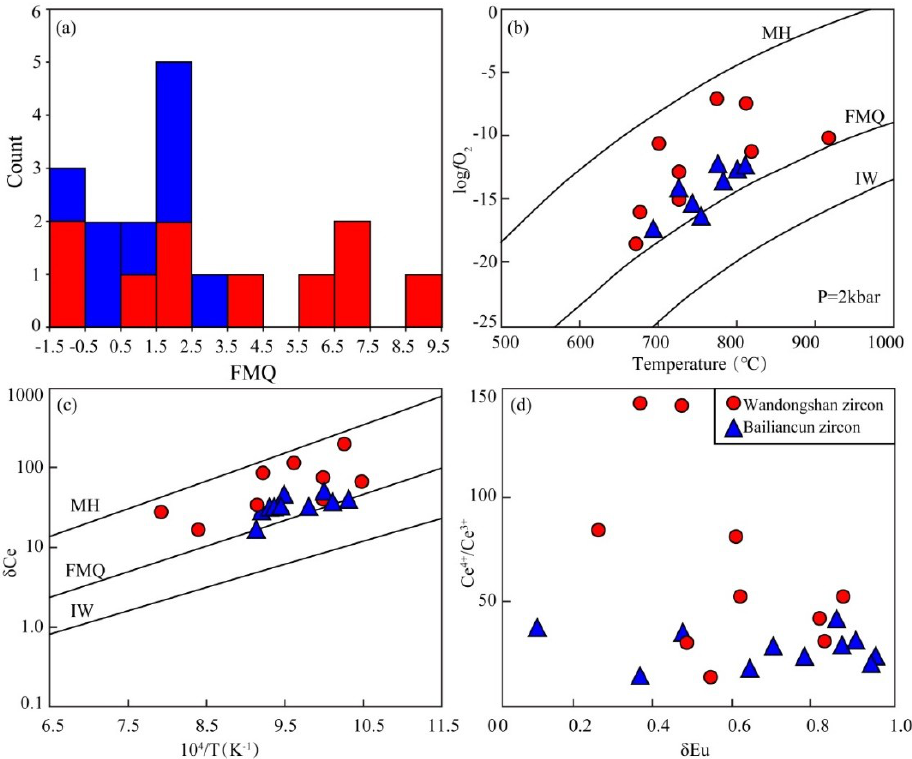
Figure 5. Magmatic oxidation state of intrusions from the Wandongshan and Bailiancun district, estimated from zircon. ( a ) Magma oxidation state of the Wandongshan and Bailiancun porphyries [41]; ( b ) Zircon log f O 2 vs. temperature; ( c ) linear relations for zircon Ce anomaly vs. 10 4 /T; ( d ) zircon Ce 4+ /Ce 3+ vs. δEu [44]. MH: magnetite-hematite buffer curve; NNO: nickel-nickel oxide buffer curve; FMQ: fayalite-magnetite-quartz buffer curve; IW: iron-wustite.